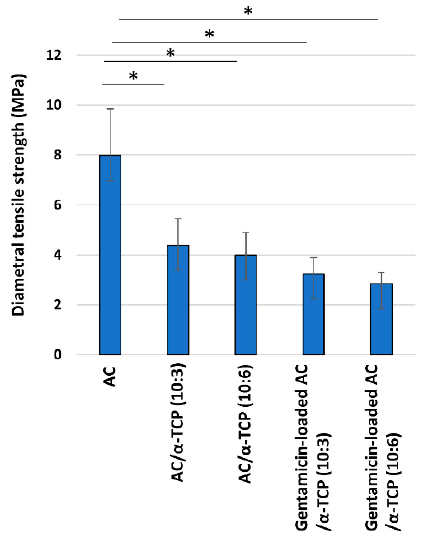
Figure 3. Diametral tensile strength of the AC/ α -TCP and gentamicin-loaded AC/ α -TCP composites. * p < 0.05, Tukey ’ s test.